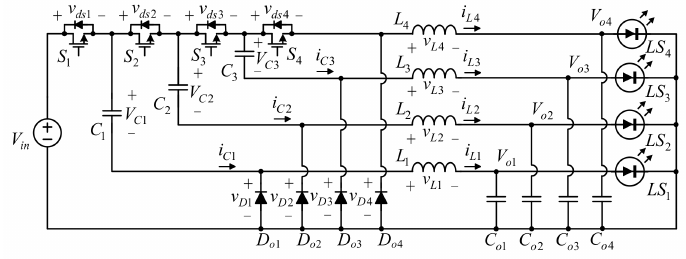
Figure 2. LED driver with automatic current